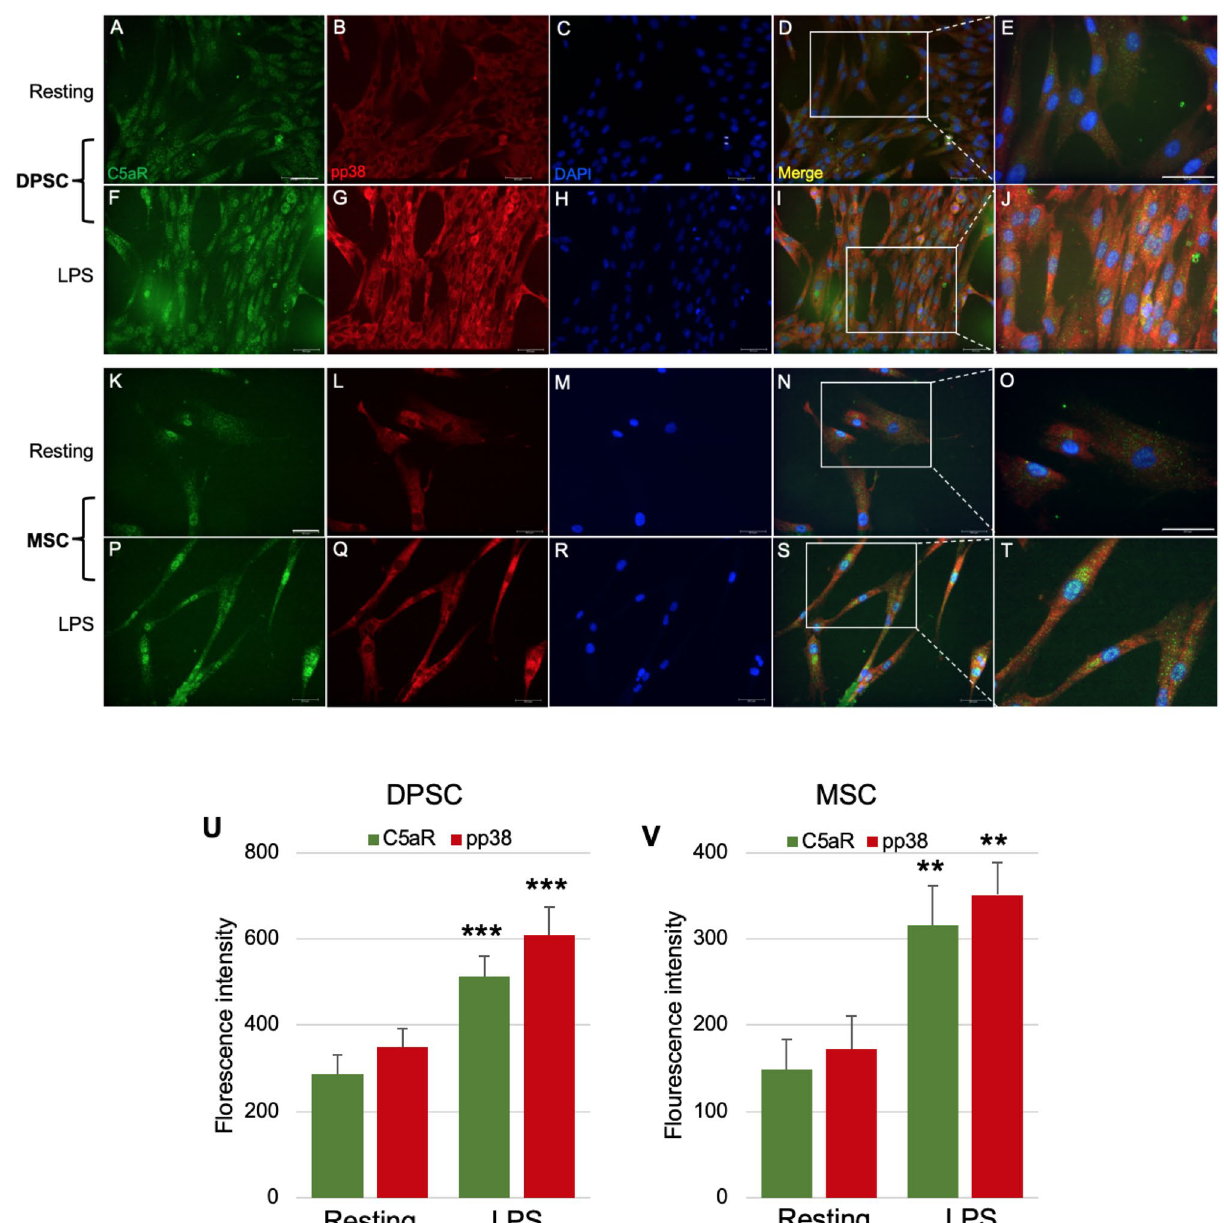
Figure 6. C5aR and pp38 expression in DPSCs and BM-MSCs. Cells were cultured for 3 days and then stimulated with LPS for 1 h, and fixed and stained accordingly. Immunofluorescence double staining was used to analyze the expression of C5aR and pp38. Anti-C5aR (green) and anti-pp38 (red) were found highly co-localized in the cytoplasm of DPSCs ( A – J ) and BM-MSCs ( K – T ) in LPS-stimulated cells. For each condition, negative controls, performed by replacement of the C5aR and pp38 primary antibodies and secondary antibody used to detect C5aR were Alexa-488 (green) and pp38 through Alexa-594 (red); nuclei were counterstained with DAPI (blue). ( U , V ) Bar graphs showing the fluorescence intensity of C5aR and pp38 in resting and LPS- stimulated DPSCs and BM-MSCs. ( E , J , O , T ) are higher magnification views of the areas indicated in ( D , I , N , S ). ** p < 0.01 and *** p < 0.001 versus untreated control of resting cells (n = 3). Scale bars: 50